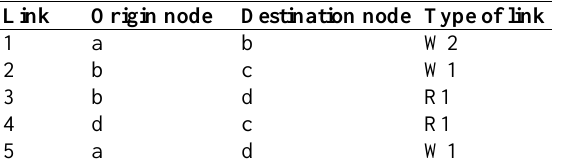
Figure 2. Partial virtual network Table 1. Real